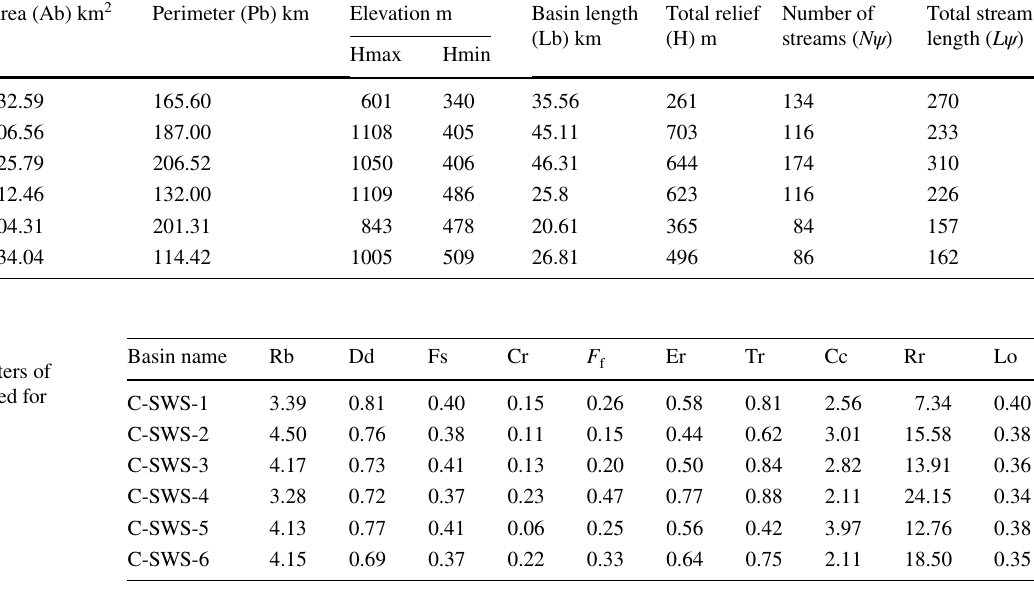
Table 3 Various morphometric parameters of Champua sub-watershed for Baitarani River Sub-basin name